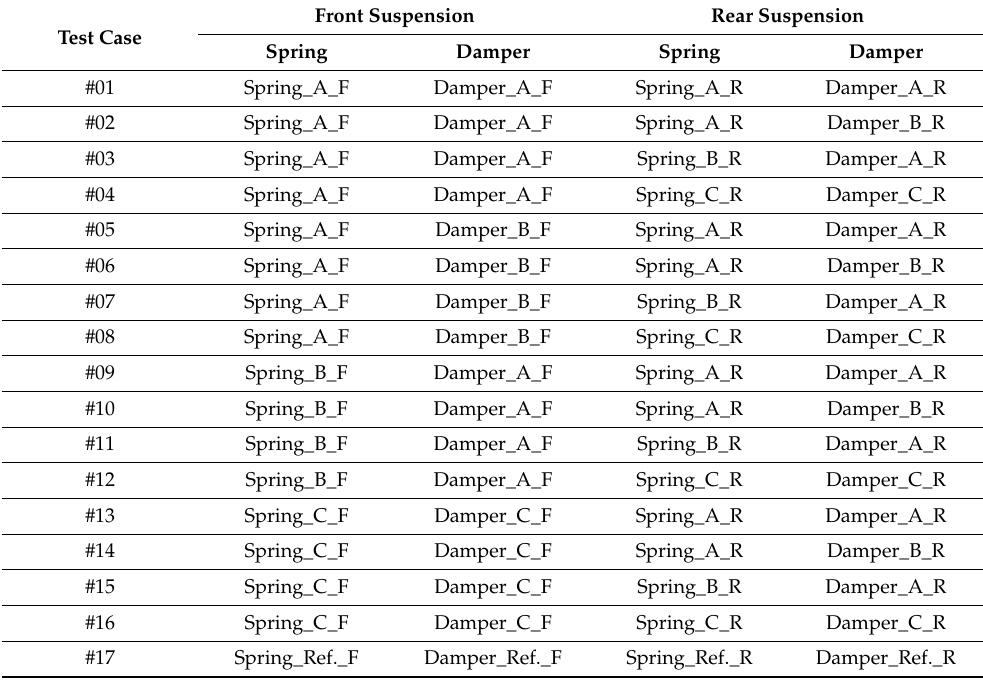
Table 4. Suspension parts used in cornering test scenario.